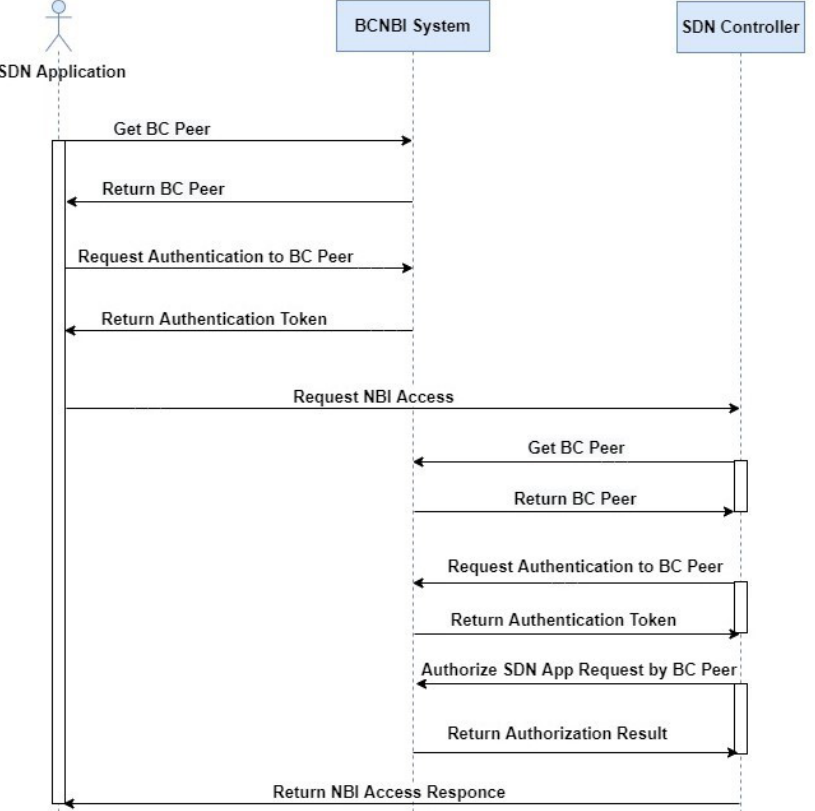
Figure 3. Main scenario and high-level interaction of the proposed